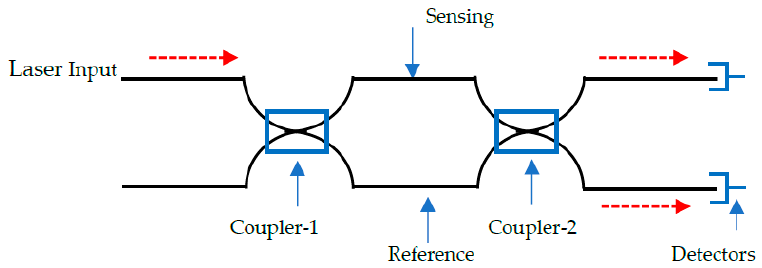
Figure 4. A fibre optic Mach-Zehnder interferometer (MZI) (after [93]).